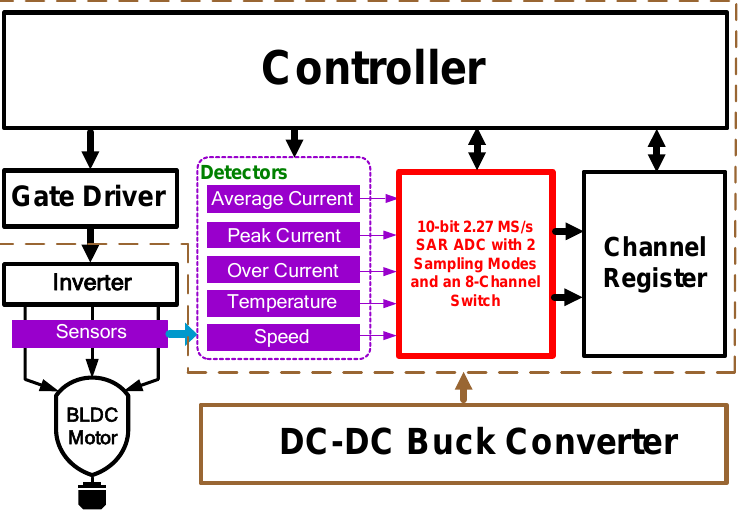
Figure 1. Proposed control circuits of electric vehicle for BLDC motor.